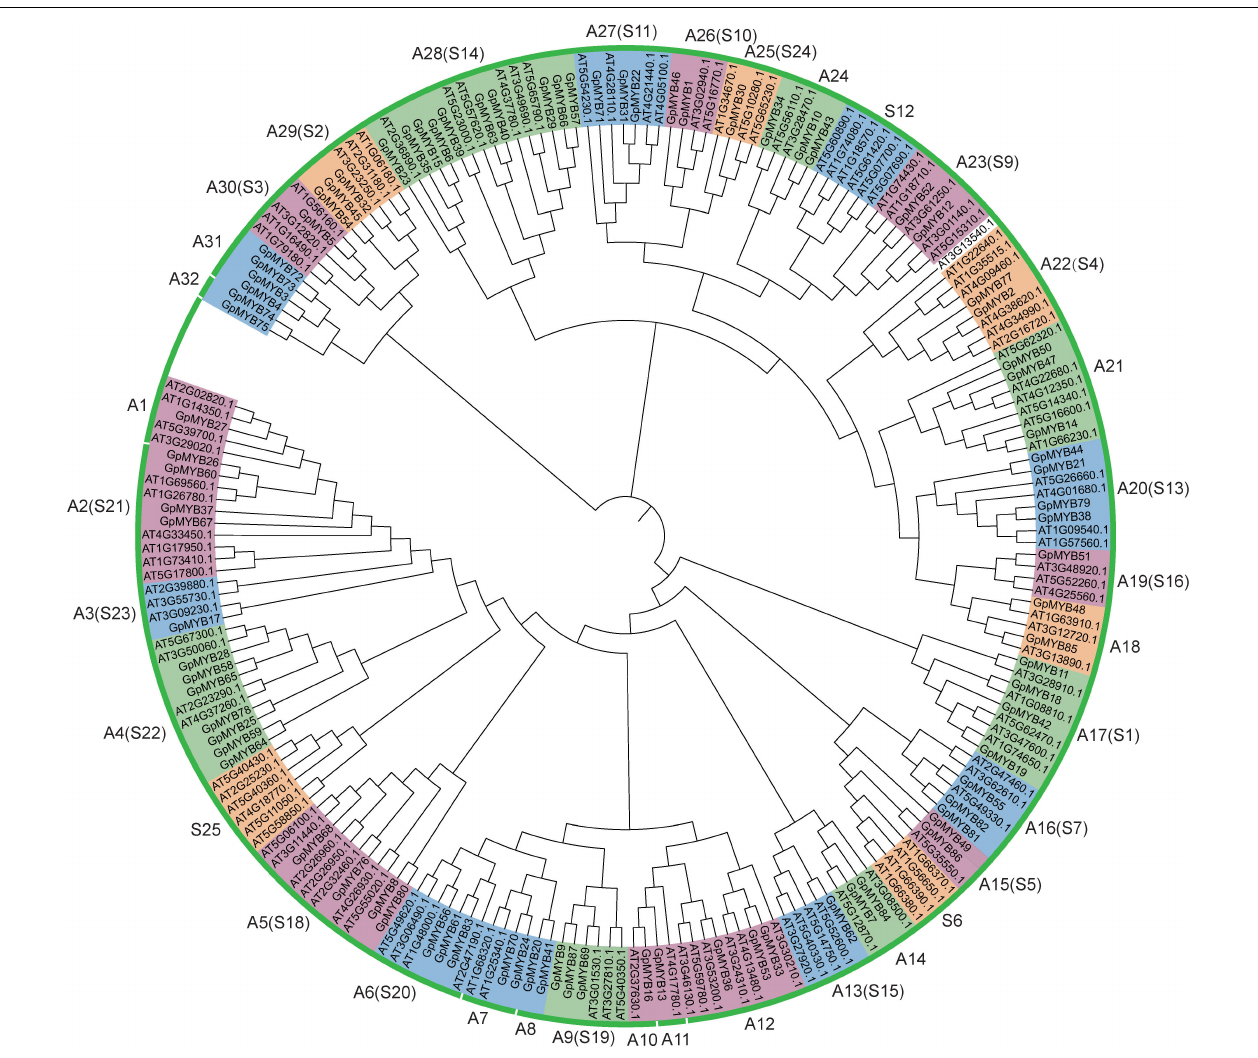
FIGURE 1 | Phylogenetic tree comparison of R2R3-MYB proteins between Gynostemma pentaphyllum ( G. pentaphyllum ) and Arabidopsis thaliana ( A. thaliana ). A maximum likelihood (ML) phylogenetic tree, including full length of 87 R2R3-GpMYB and 124 R2R3-AtMYB protein sequences, was generated using the Jones–Taylor–Thornton (JTT) algorithm via the FastTree software. The genes of the R2R3-GpMYB family were divided into 32 subgroups (designated as A1–A32). In addition, the classification method of A. thaliana (Stracke et al., 2001) was adopted.